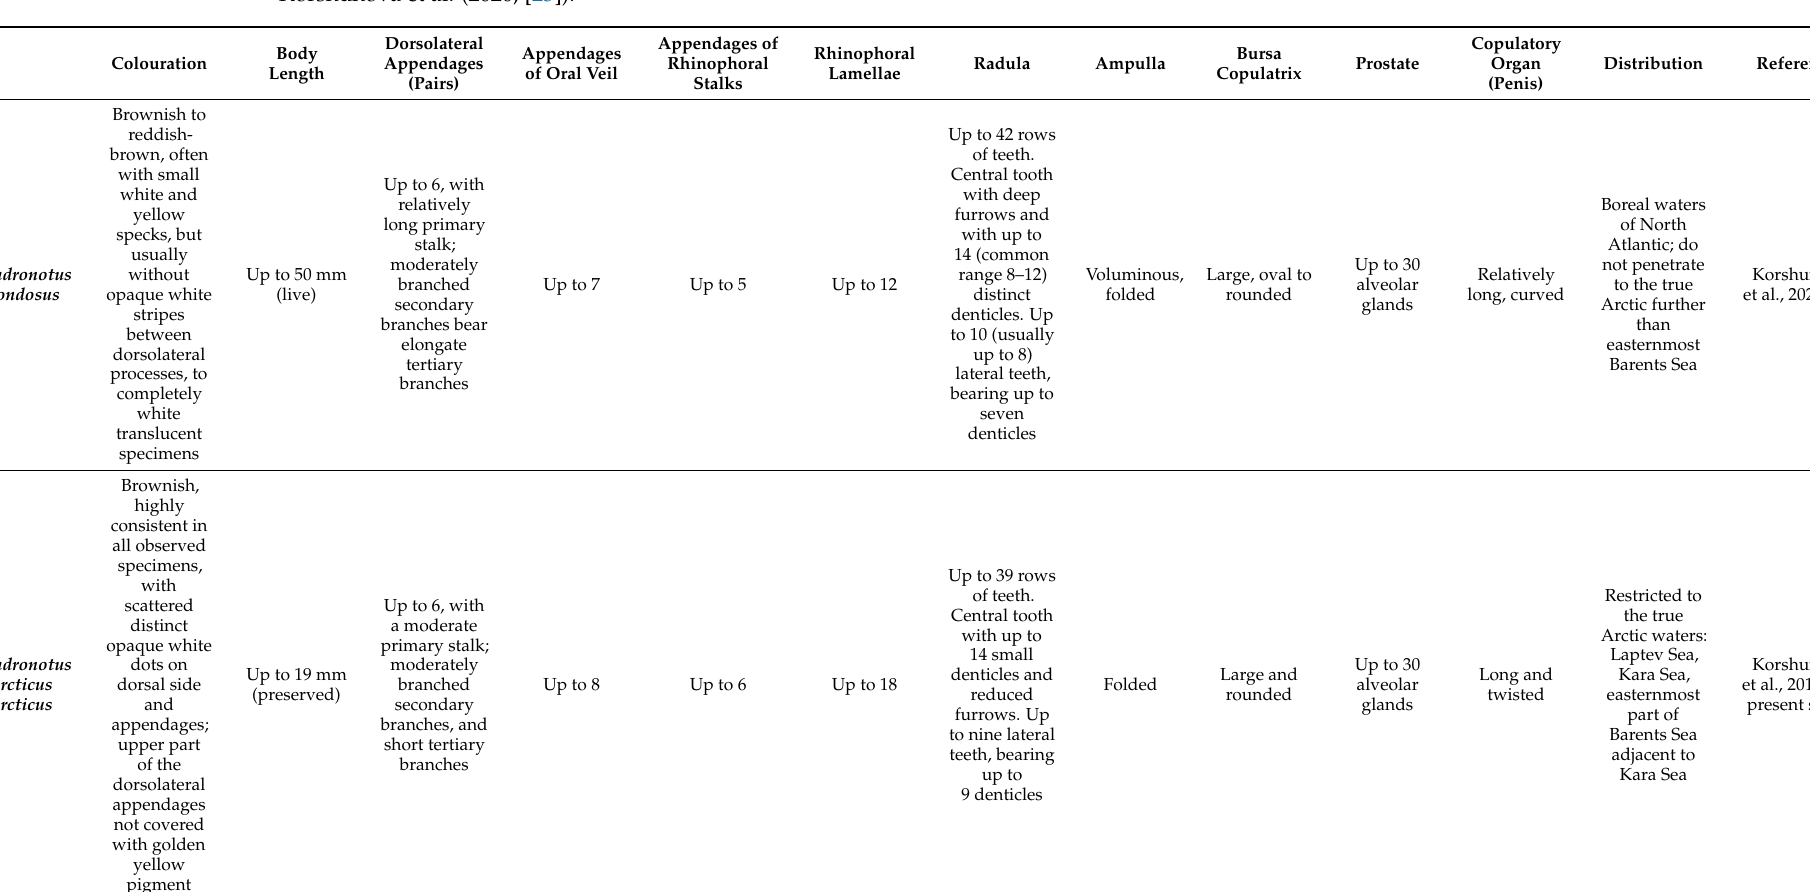
Table 2. Key morphological characters of Dendronotus taxa. For a comparison with other species of the genus Dendronotus , see the detailed synopsis of Korshunova et al. (2020,